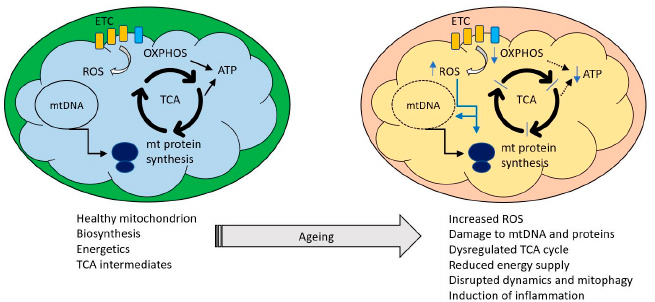
Figure 1. Healthy mitochondria perform a variety of functions including ATP production and synthesis of a variety of metabolites required for cell maintenance. Major processes are indicated by black arrows, blue arrows indicate changes occurring during ageing. Ageing is associated with an increasing impairment of these functions, manifested as excessive reactive oxygen species (ROS) production, oxidative damage to mitochondrial components, reduced ability to supply ATP, dysregulation of the tricarboxylic acid cycle and an increase in mitochondrially driven